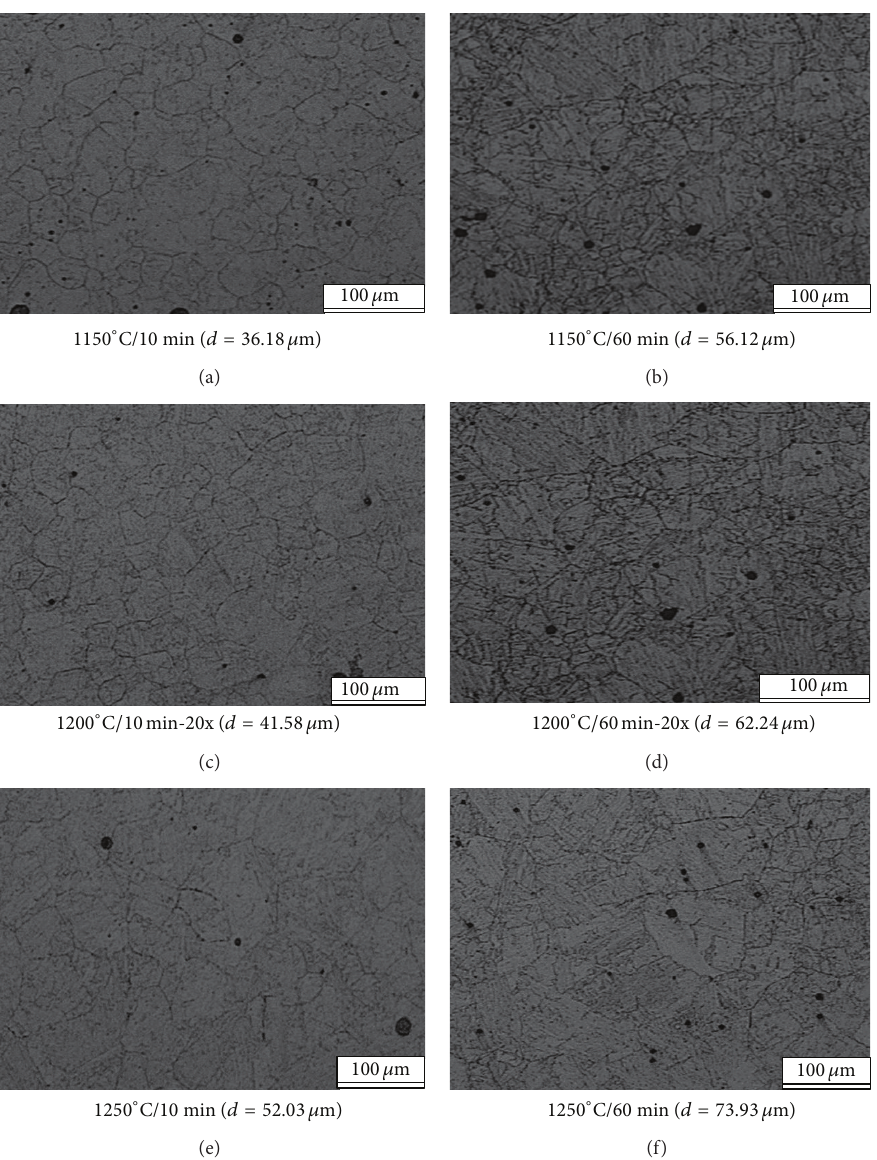
Figure 2: Microstructure micrographs X70 grade after being heat treated at three temperatures (1150 ∘ C, 1200 ∘ C, and 1250 ∘ C) and holding times (10min. and